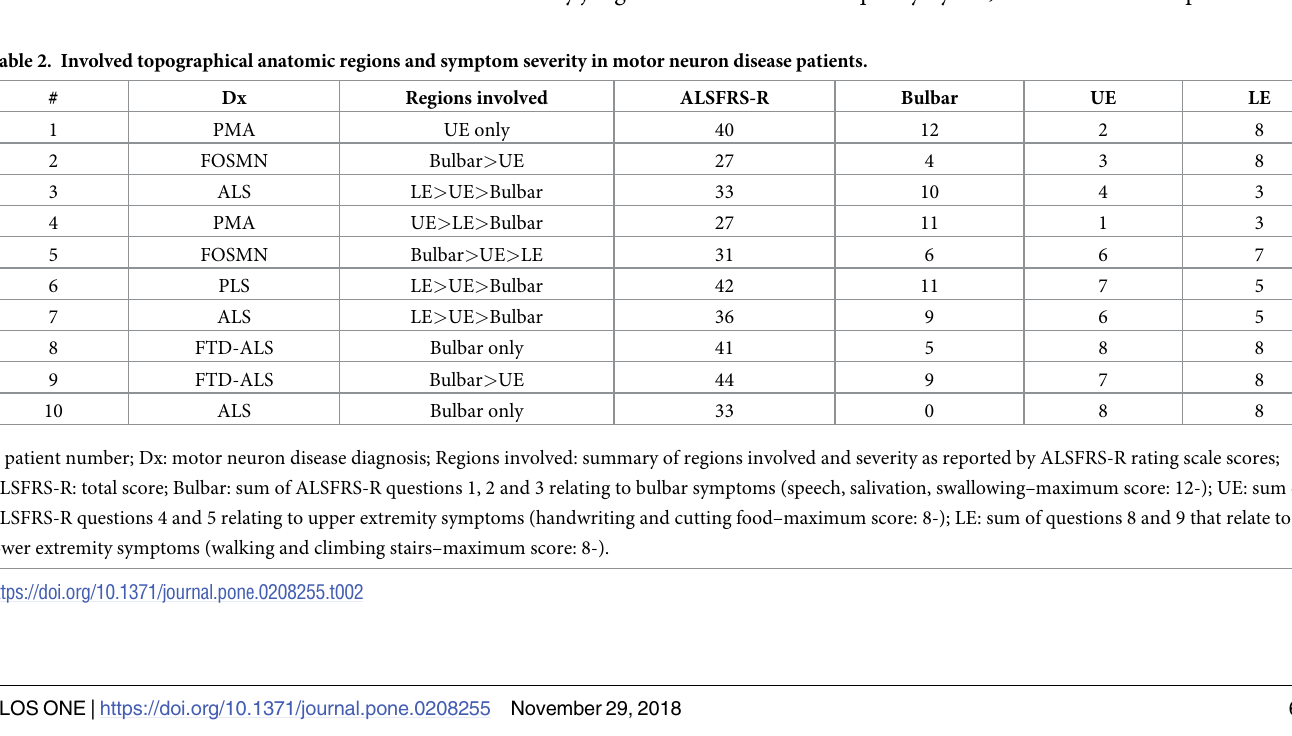
Spinal cord PSIR images of the HC previously published did not show any abnormalities. On HC, the MRI technologists never had to repeat an acquisition due to suboptimal quality. The inter-rater reliability among all GM area measurements performed by the three opera- tors in the HC training dataset and the published data demonstrated an ICC of 0.9856. These results on the HC training data subset support the use of previously published data as norma- tive reference for the present study.